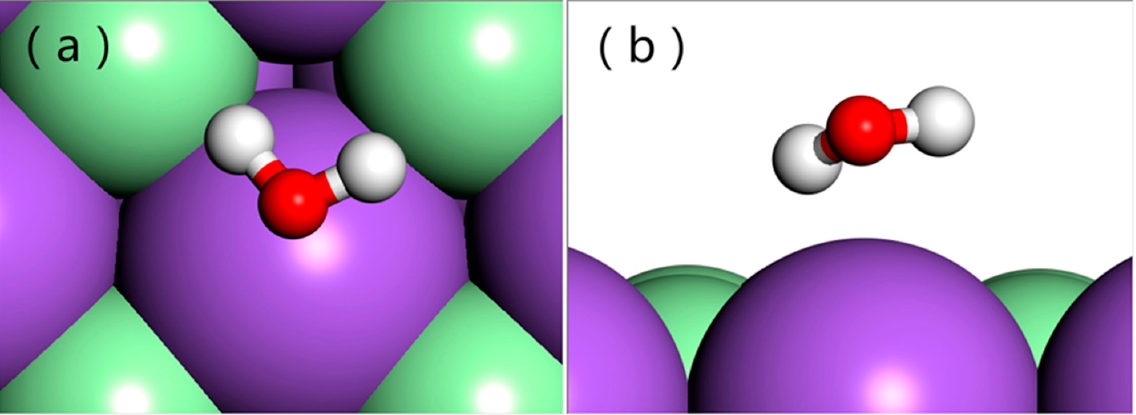
Figure 3. Refined structure of the water monomer on the NaCl(001) surface. Image ( a ) is the top view and ( b ) is the side view.